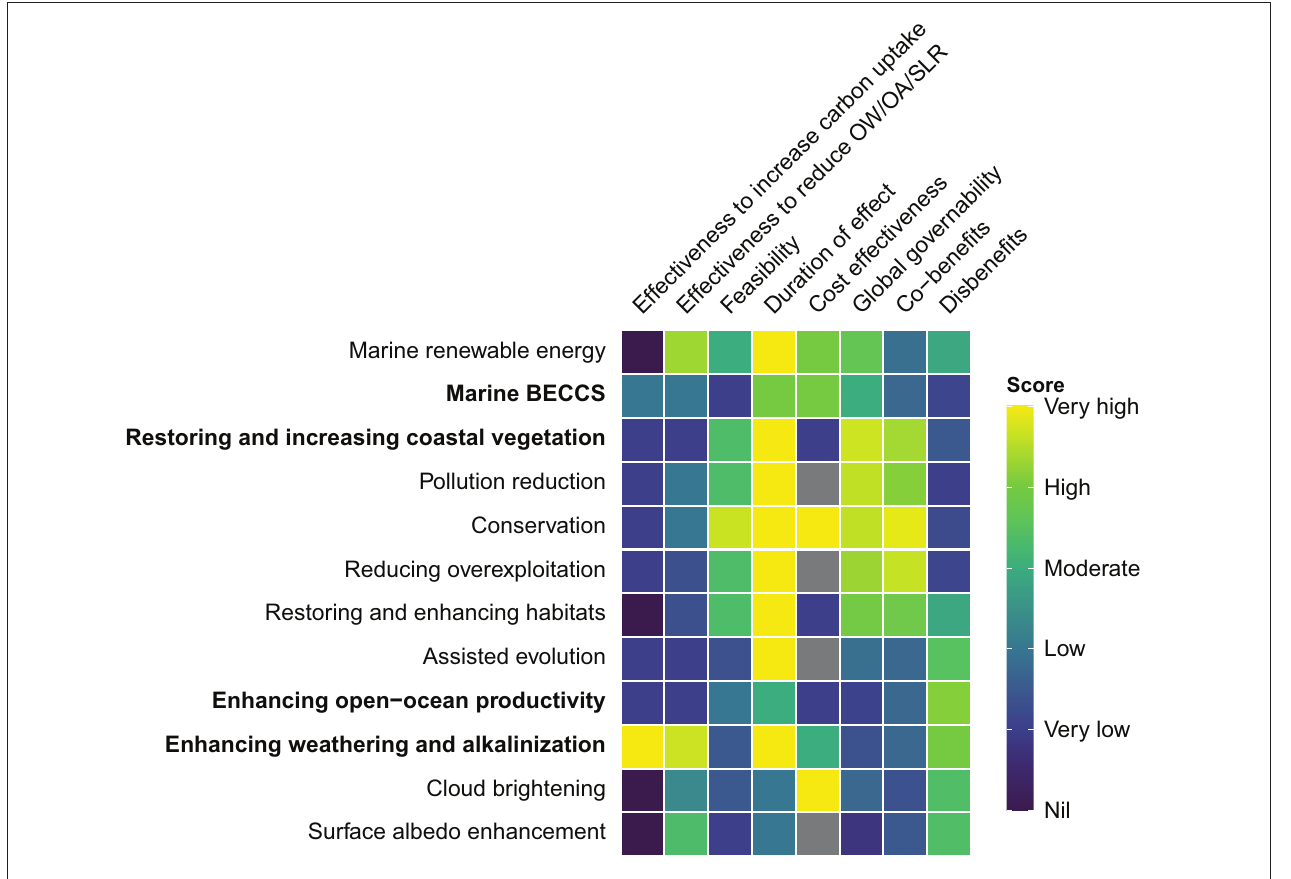
FIGURE 1 | Assessment of ocean negative emissions approaches (in bold) compared with other ocean-based measures. Based on Gattuso et al. (2018), except for marine BECCS (see SM3 in Supplementary Material ), with the following changes: Vegetation and Alkalinization are only considered at global scale except the co-benefits and disbenefits which are considered at local scale. Two criteria are newly defined by combining criteria assessed earlier. Feasibility is the mean of Technological readiness and Lead time until full potential effectiveness. Effectiveness to reduce OW/OA/SLR (ocean warming, ocean acidification and sea level rise) is the mean of the effectiveness to Moderate warming, Moderate acidification and Moderate sea level rise. Gray tiles indicate criteria not assessed for the corresponding measure. Further information on the measures and criteria are available in Supplementary Material (SM1 and SM2).